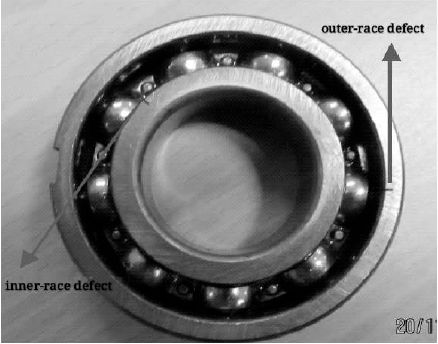
Figure 13. The bearing with compound fault.